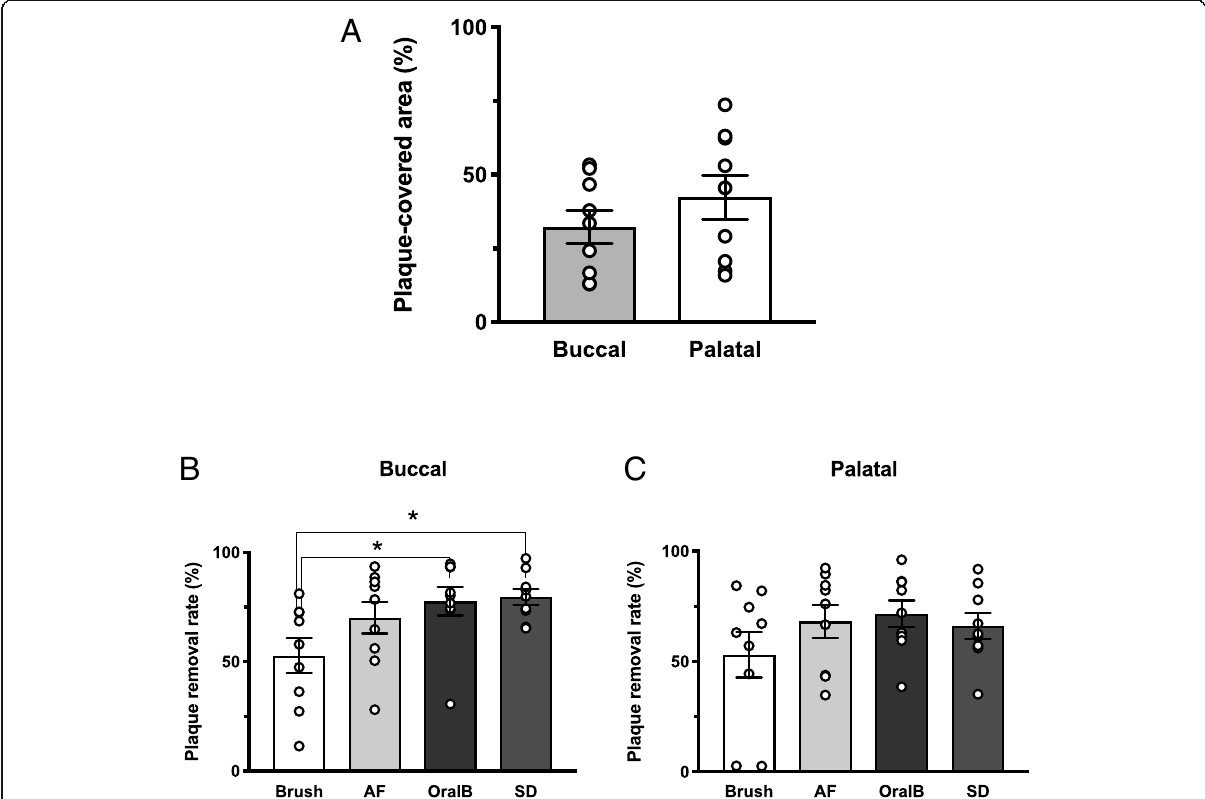
Fig. 4 Comparison of plaque in the buccal and palatal areas and plaque removal rates. a The plaque-covered areas in the palatal side are larger than those in the buccal side. b The SD and OralB plaque removal rates in the buccal area were significantly higher than those of manual brushing; no significant differences were observed among the other instruments. c There were no significant differences in the plaque removal rates in the palatal side among instruments. * p <